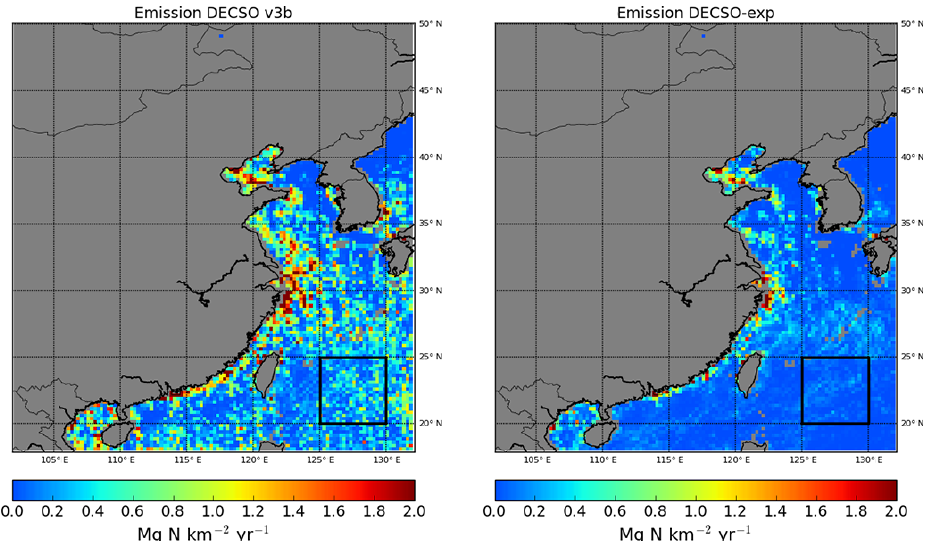
Figure 2. The comparison of NO x emissions over the ocean derived with DECSO v3b (left) and DECSO-exp (right).